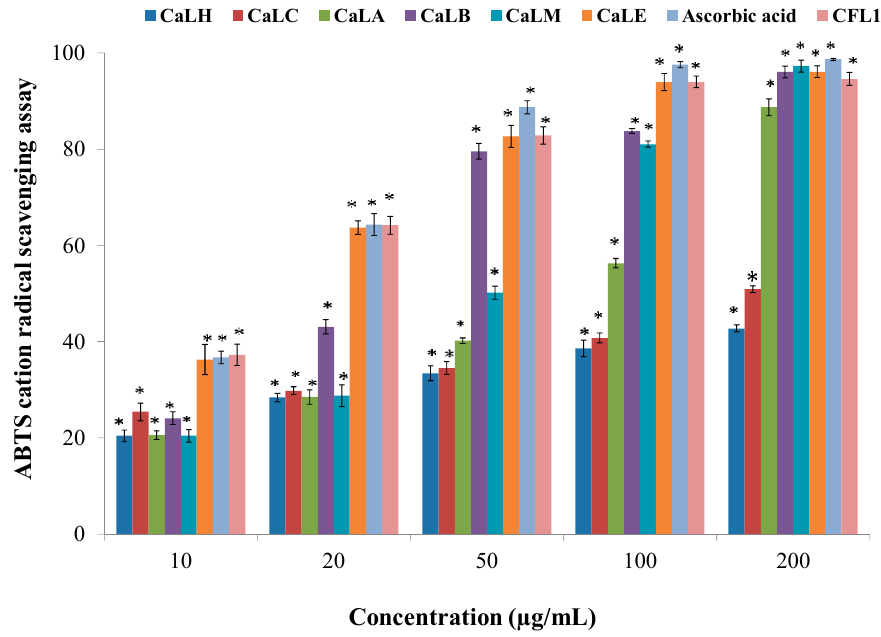
Figure 1. ABTS (2,2'-azino-bis(3-ethylbenzothiazoline-6-sulfonic acid)) cation radical scavenging effect of extract/fractions from C. fistula and standard ascorbic acid (values are represented as percent of control). * indicates statistically significant difference at ( p ≤ 0.05) (For each fraction n = 18).